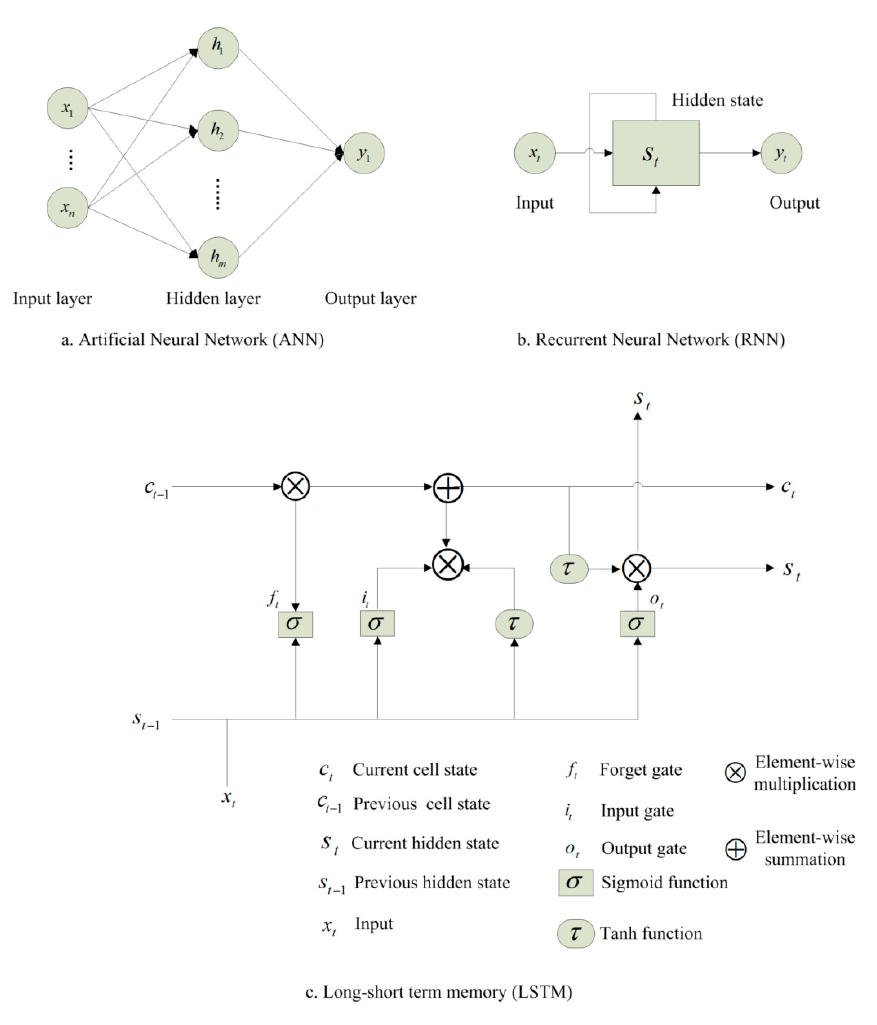
Figure 1. The schematic architecture: ( a ). Artificial neural network (ANN), ( b ). Recurrent neural network (RNN), ( c ). Long short-term memory (LSTM).